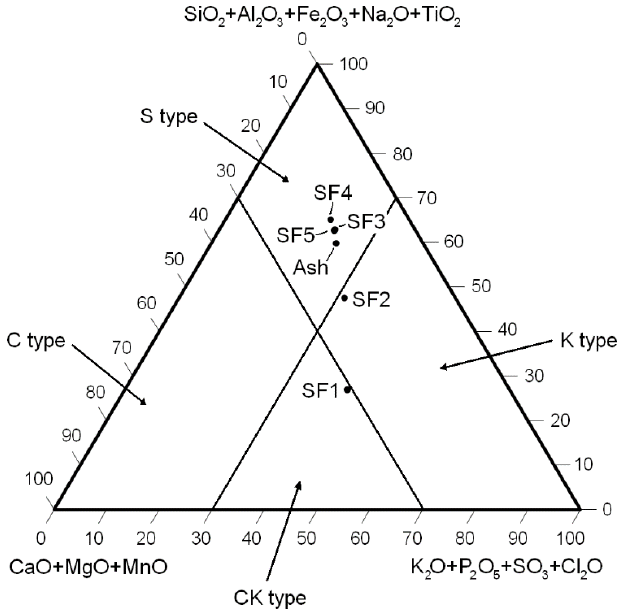
Figure 4. Triangular ash diagram with the different size fractions.